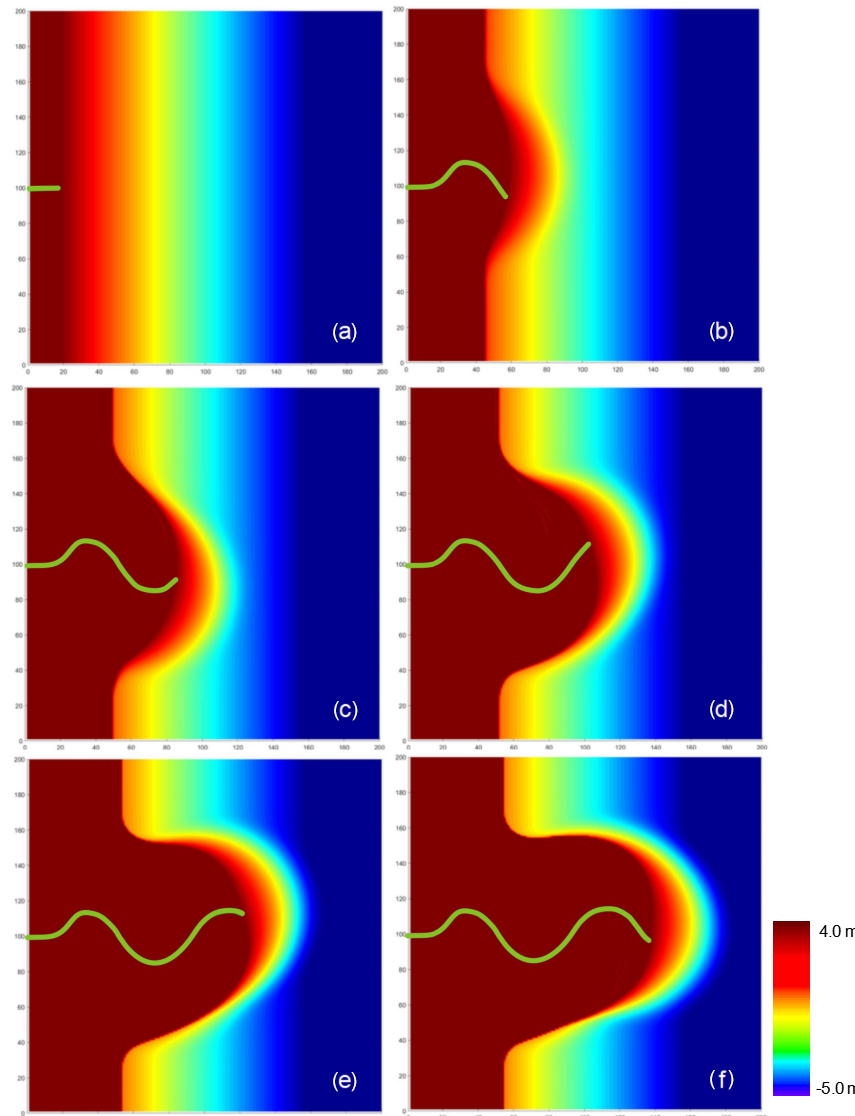
Figure 7. Plane view of Model 1 results: (a) t = 0Myr, (b) t = 2Myr, (c) t = 4Myr, (d) t = 6Myr, (e) t = 8Myr and (f) t =